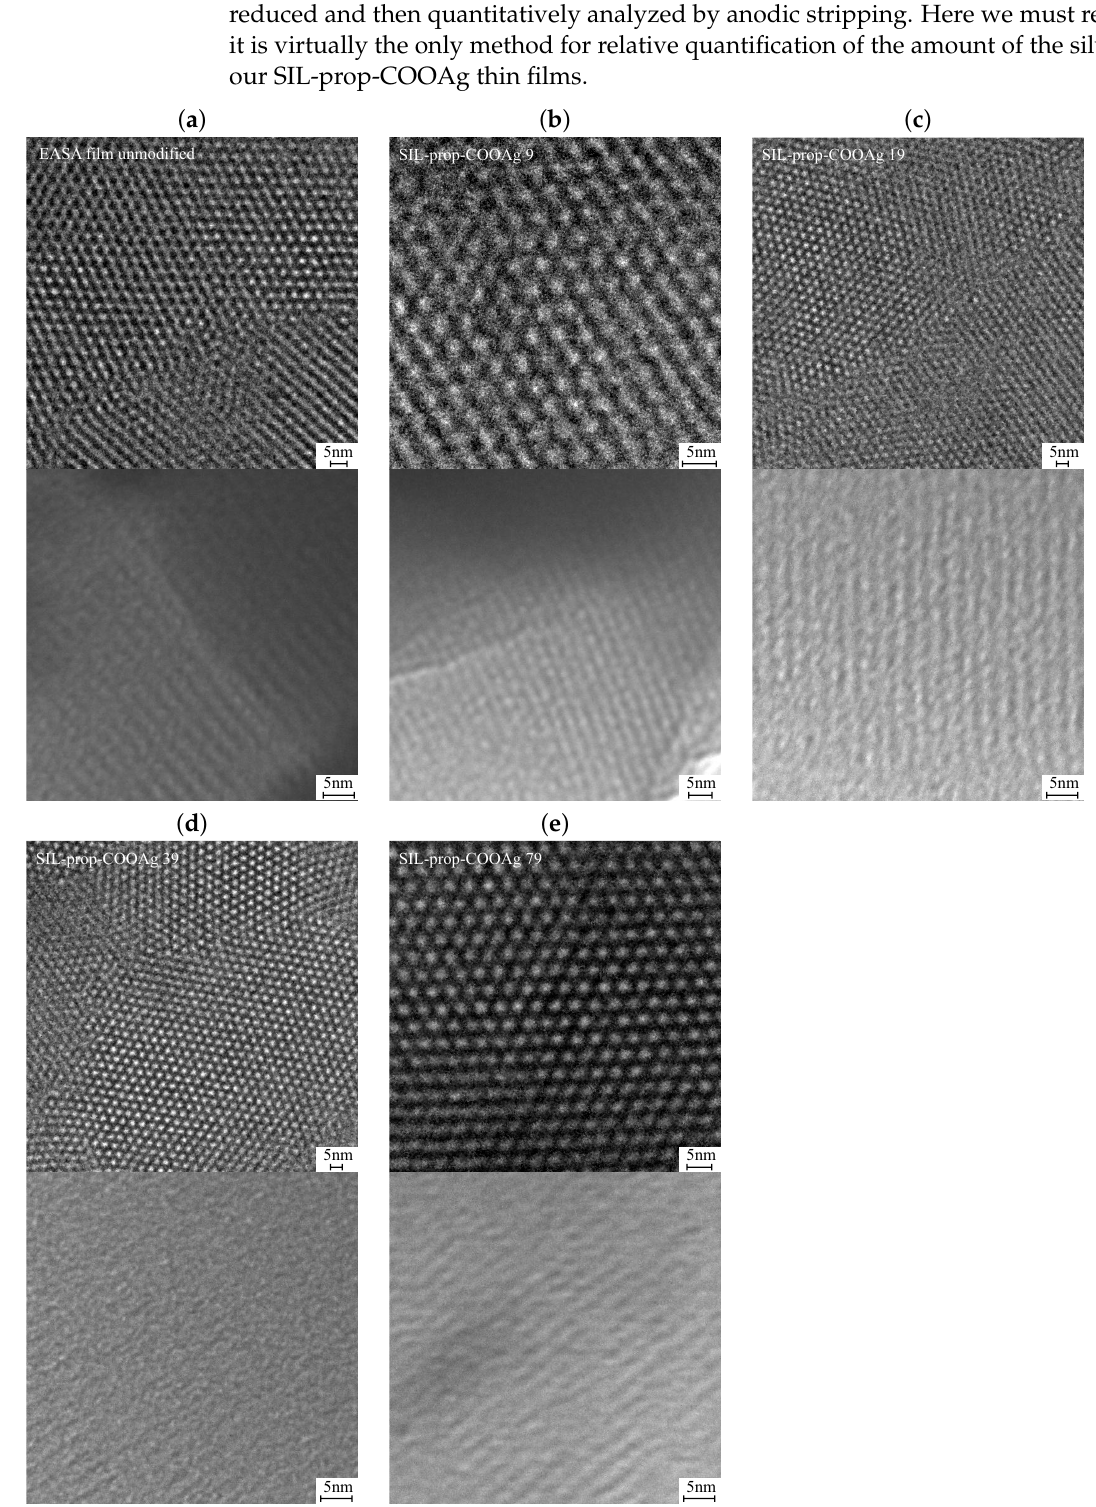
Figure 4. TEM images of the porous silica thin layers unmodified ( a ) and containing different concentrations of the functional groups ( b – e ). Figures show plan views (upper images) and cross-section views (bottom